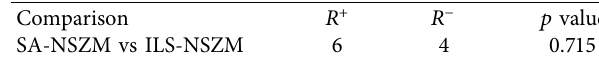
Table 2: Wilcoxon signed ranks test results.